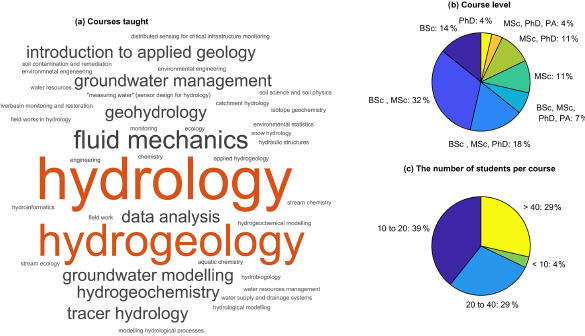
Figure 3. These respondents indicated which courses they taught, represented as a word cloud (a) . The larger the font, the more re- spondents indicated teaching the course (multiple answers were possible). The percentage of respondents teaching BSc- to PhD- level or post-academic (PA) courses (b) . The percentage of re- spondents indicated to have had < 10 up to > 40 students in their course (c)